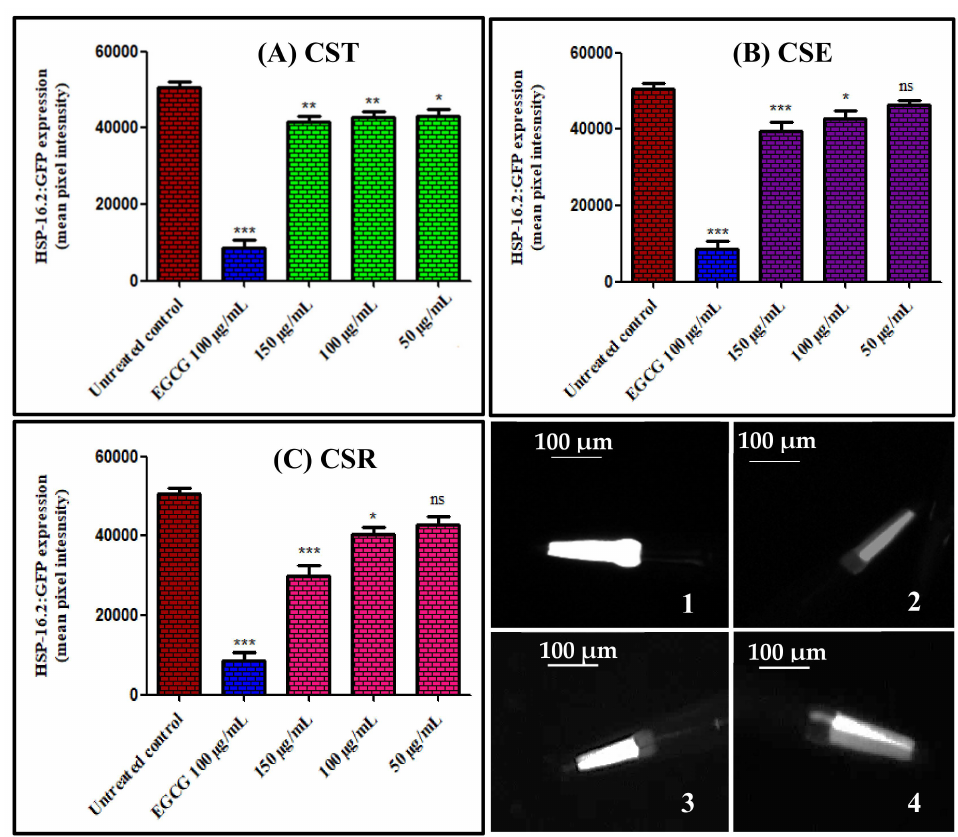
Figure 3. Hsp-16.2/GFP expression in Caenorhabditis elegans pre-treated with different concentra- tions (50, 100, and 150 µ g/mL) of extracts and fractions of C. speciosum leaves; ( A ) CST, ( B ) CSE, and ( C ) CSR estimated as mean pixel intensity. Images of C. elegans by fluorescence microscopy (1) untreated control group, (2) pre-treated with 100 µ g/mL of EGCG, (3) pre-treated with 50 µ g/mL of CSE, and (4) pre-treated with 150 µ g/mL of CSR; untreated control receives juglone treatment; EGCG = Epigallocatechin gallate (100 µ g/mL) after juglone treatment; CST, CSE, and CSR groups receives (50, 100, and 150 µ g/mL) of CST, CSE, and CSR after juglone treatment; * p < 0.05, ** p < 0.01, and *** p < 0.001. ns—no